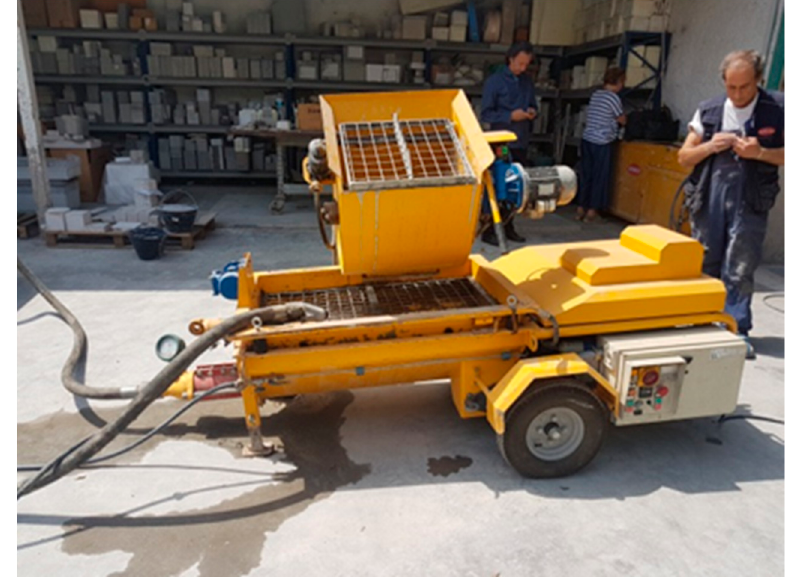
Figure 4. S8 EVM machinery creation of TEK.SP.ED s.r.l. used for eco-mortar for plaster mix design.